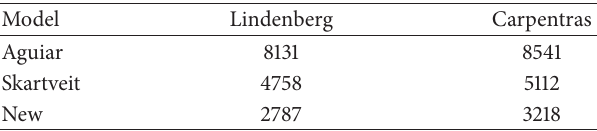
Table3:Rootmeansquareerrors(RMSE)ofthefrequencydistribu- tions of irradiance gradients of modelled data versus measurement in W/m 2 . The new model is able to produce significantly smaller values of RMSE than the models of Aguiar and Skartveit for both locations, Lindenberg, 2005, and Carpentras,